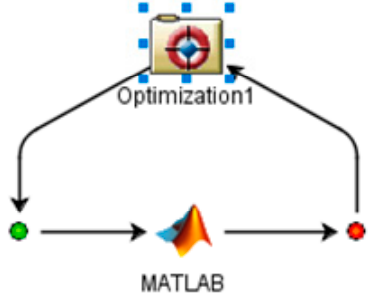
Figure 14. Optimization loop diagram. Table 4. Optimal design of the FLHD boom.